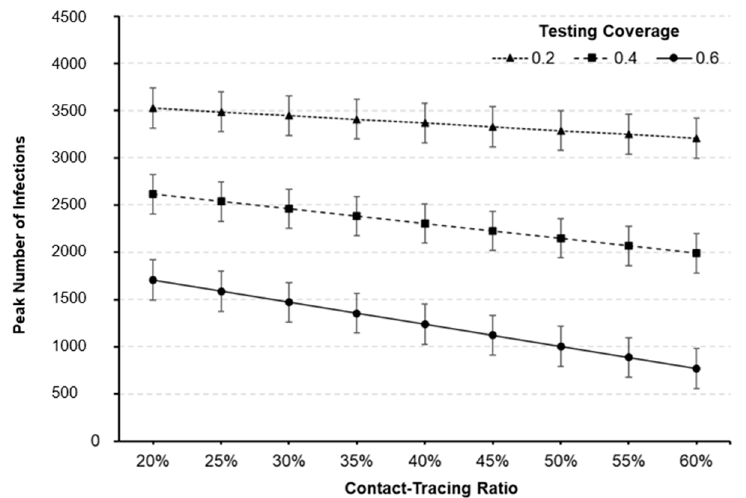
Figure 6. Predicted peak number of infections against testing coverage and contact-tracing ratio (turn-in time = 1-day). The 95% prediction intervals are represented as bar graphs at each point.